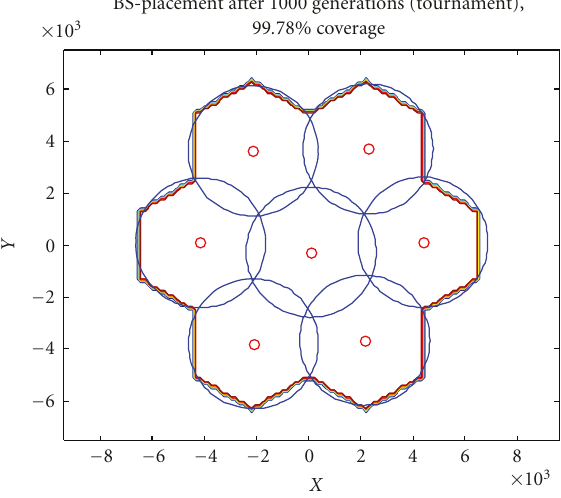
Figure 14: After the 1000th generation, base station location with roulette-wheel selection.